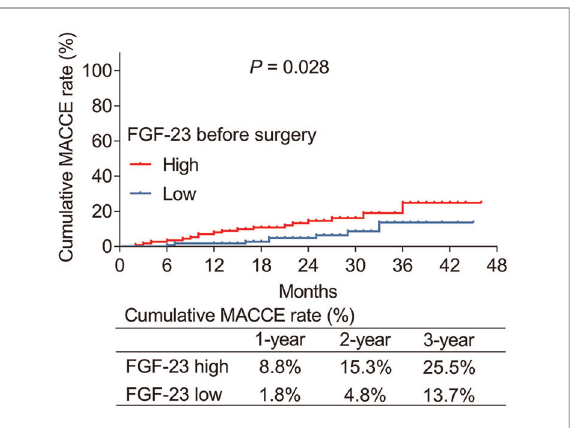
FIGURE 3 FGF-23 (before surgery) level was positively correlated with cumulative major adverse cardiac and cerebrovascular event rate in unprotected left main coronary artery disease patients receiving CABG.